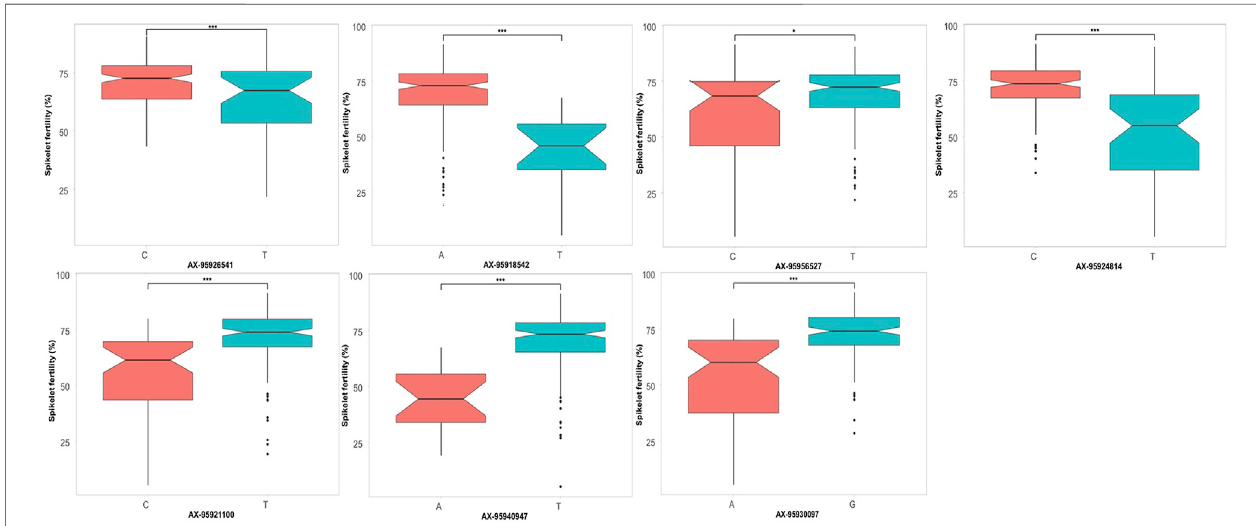
FIGURE 8 | Comparison of allelic effects of major QTNs identi fi ed in the present study for spikelet fertility under reproductive stage heat stress.